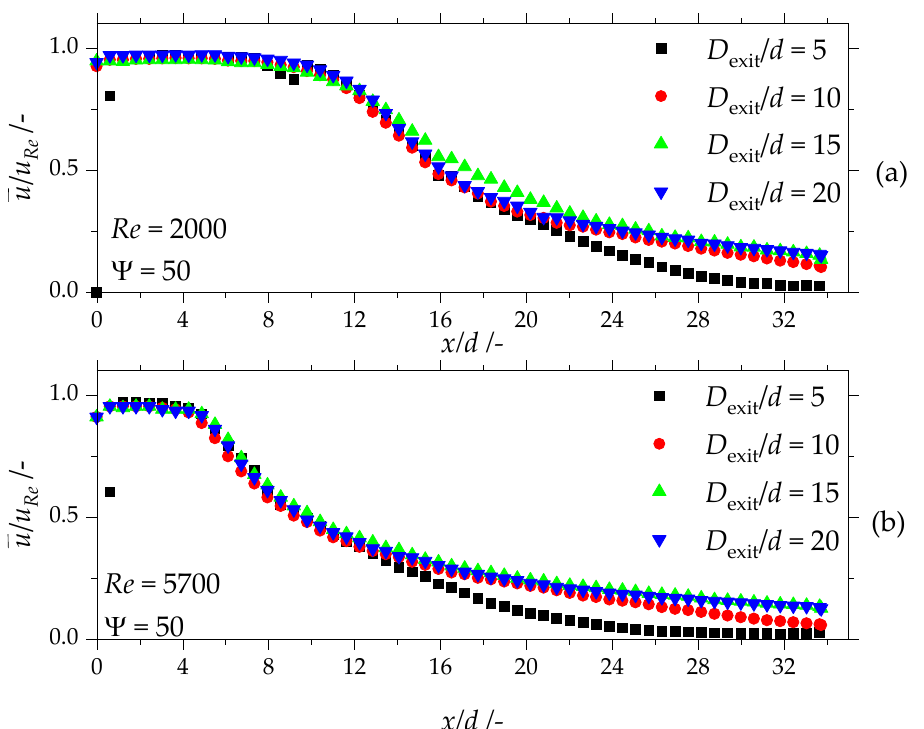
Figure 9. ( a ) Normalized velocity on the center axis of a 50-fold scaled orifice ( Ψ = 50 ) with altered outlet channel diameter ratio at a Reynolds number Re = 2000; ( b ) normalized velocity on the center axis of a 50-fold scaled orifice ( Ψ = 50 ) with altered outlet channel diameter ratio at a Reynolds number Re = 5700.